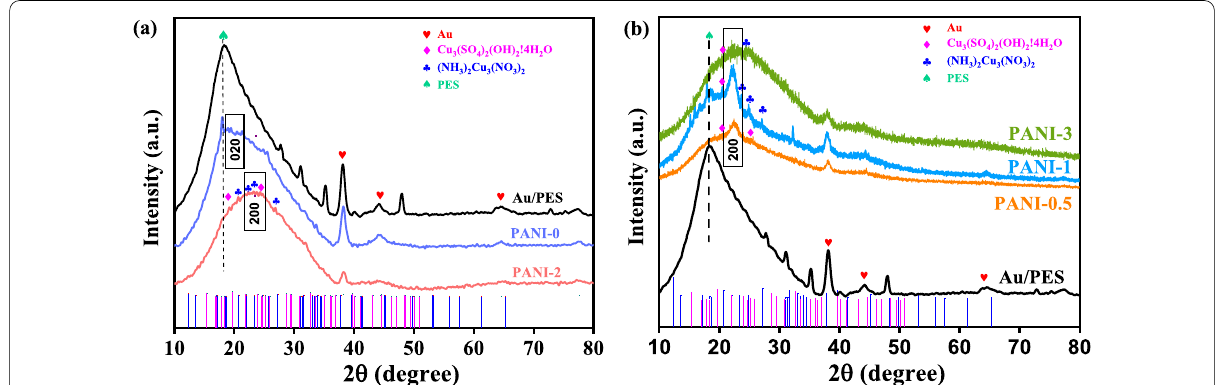
Fig. 1 a The XRD image of Au/PES substrate, PANI-0, and PANI-2 porous films. b PANI-0.5, PANI-1, and PANI-3 porous